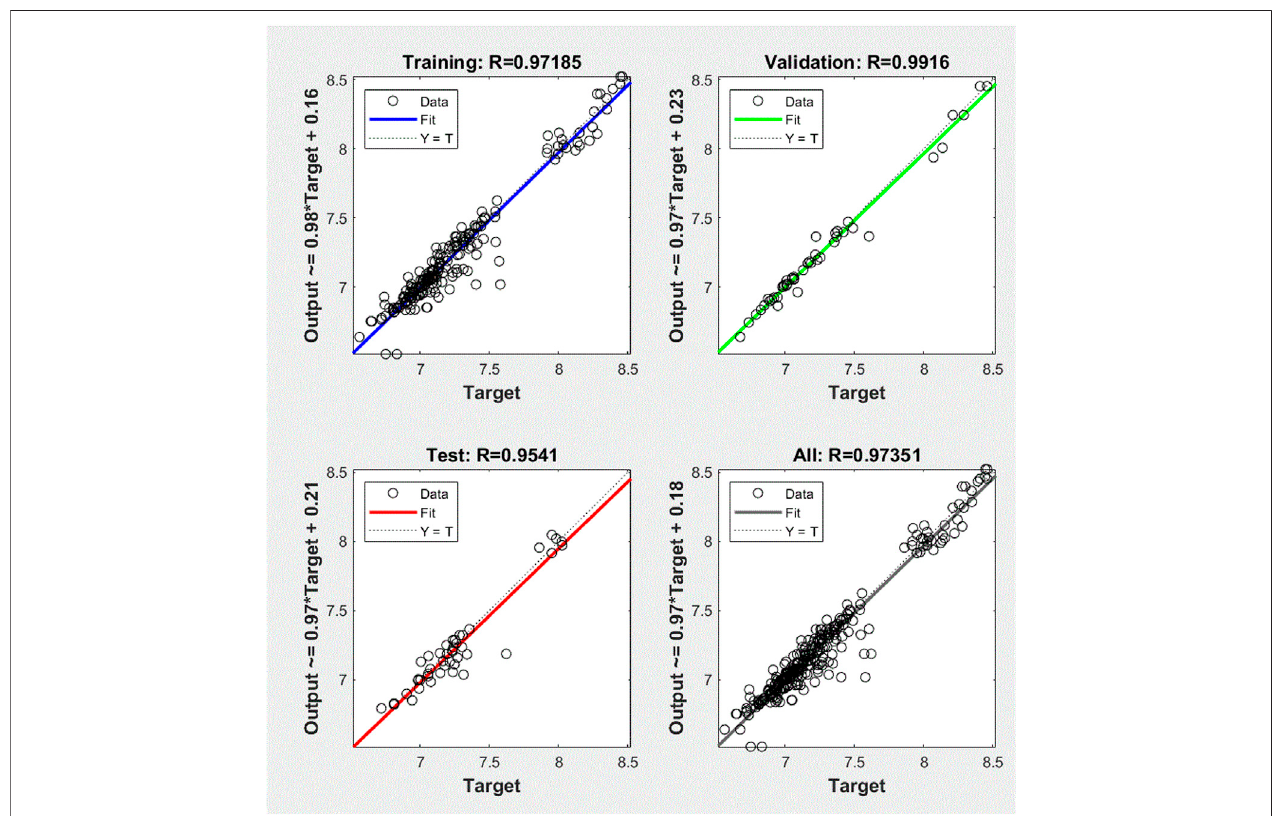
FIGURE 15 | Performance of the Trainlim function in predicting the columns ’